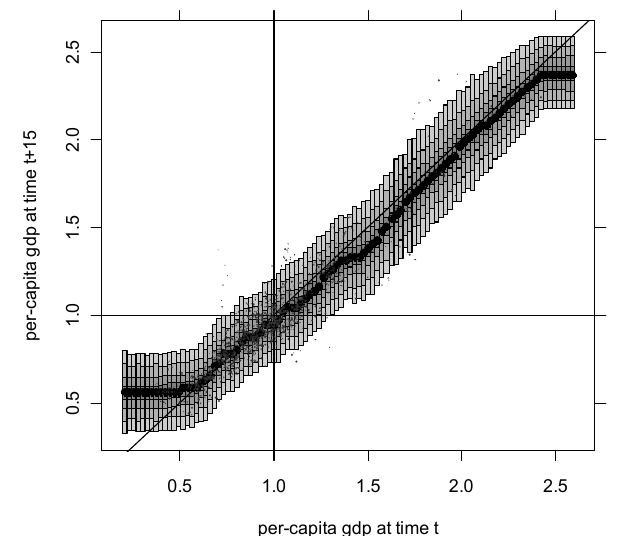
Figure A5 – Intra-Distribution Dynamics of regional per-capita income in Europe. HDR plot of conditional density for transitions of 15 years between 1980-2002. Groningen is ex- cluded from the sample. Estimates are based on a kernel density estimator with a variable bandwidth in the x direction (span = 0.50), a fixed bandwidth in the y direction (b = 0.111) and a mean function specified by a lowess smoother (span =